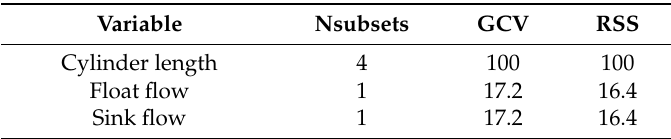
Table 6. Relative importance of variables in MARS model number one and their coefficients for feed into the vortex.